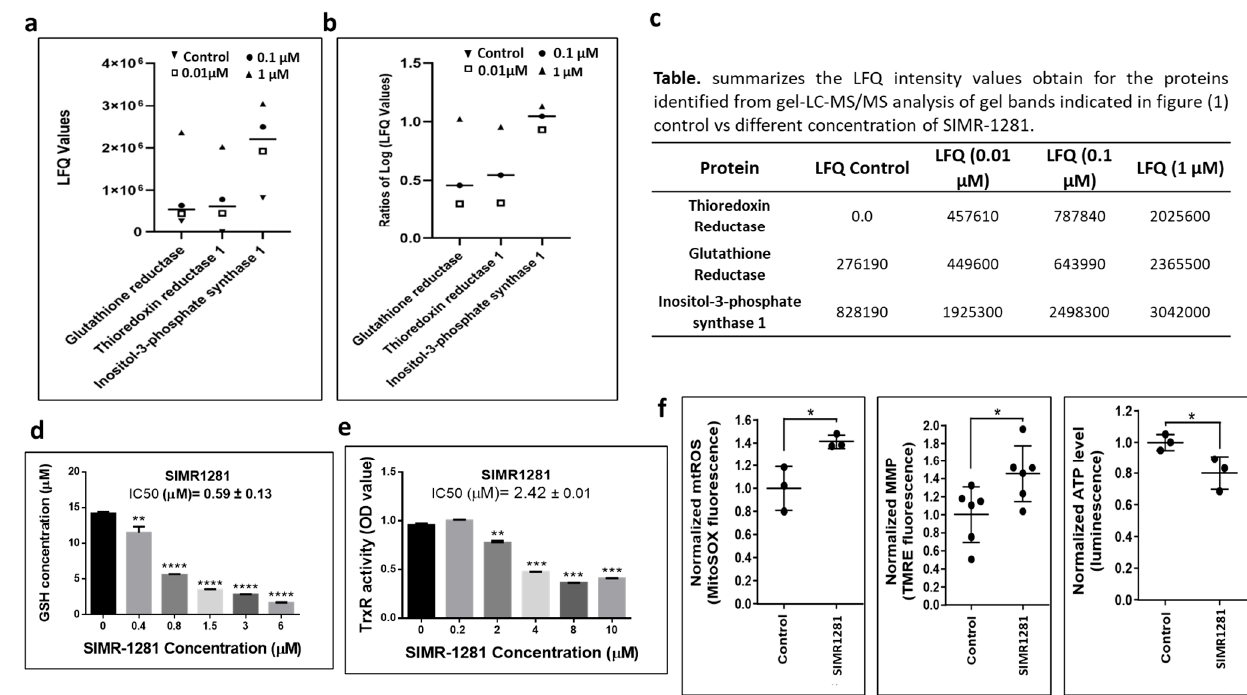
Figure 2. SIMR1281 targets the function of key proteins and modulates mitochondrial functions. ( a ) the LFQ ratios of cell lysate treated with different concentrations as indicated. ( b ) The ratios (treatment/control) of transformed LFQ values. ( c ) A table summarizes the LFQ intensity values for the identified proteins. ( d , e ) The effect of SIMR1281 on the concentration of oxidized glutathione (GSH) and thioredoxin reductase activity. Columns are mean ± SD ( n = 3). ( f ) Cellular redox potential, MMP, and ATP level upon the treatment with SIMR1281. p -value determined by two-tailed unpaired t -test. * indicates significant difference versus control at p < 0.05 (*), p < 0.01 (**), p < 0.001 (***), p < 0.0001 (****).